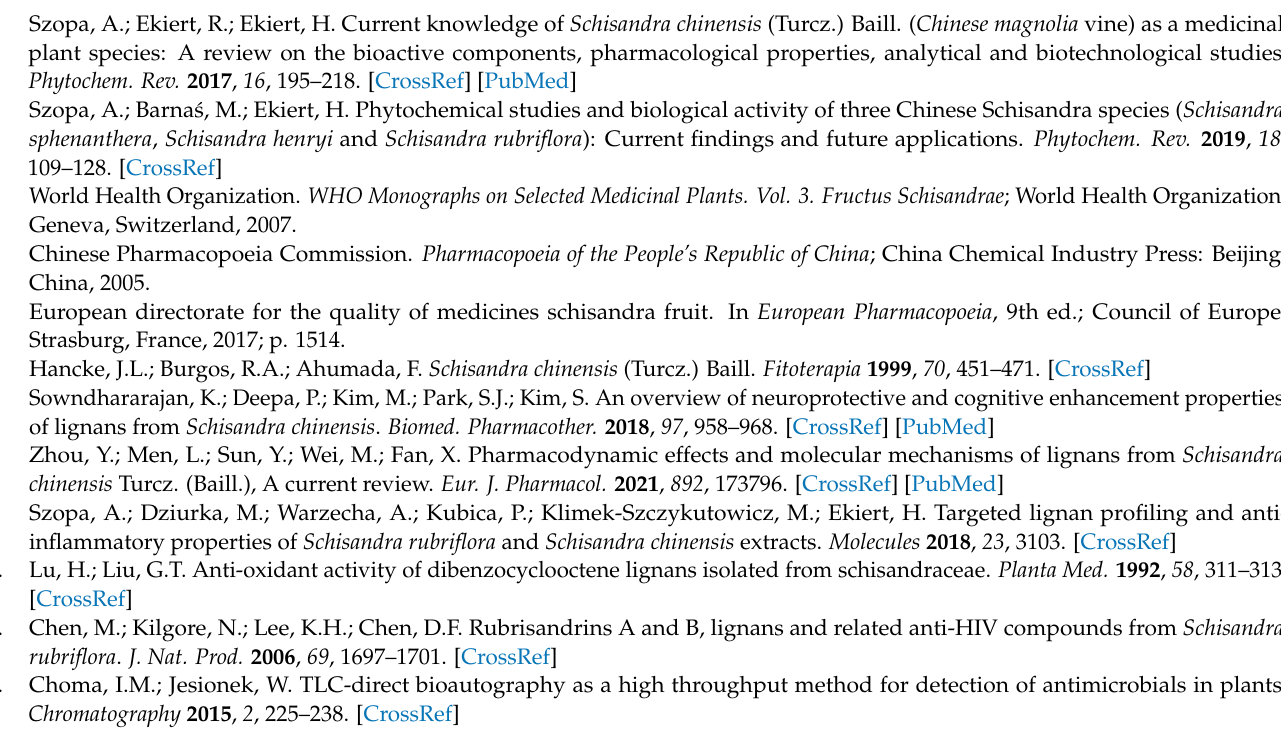
Table S4. Lignan contents vs their activities in AChE inhibition dot-blot test and information on their activities found in the